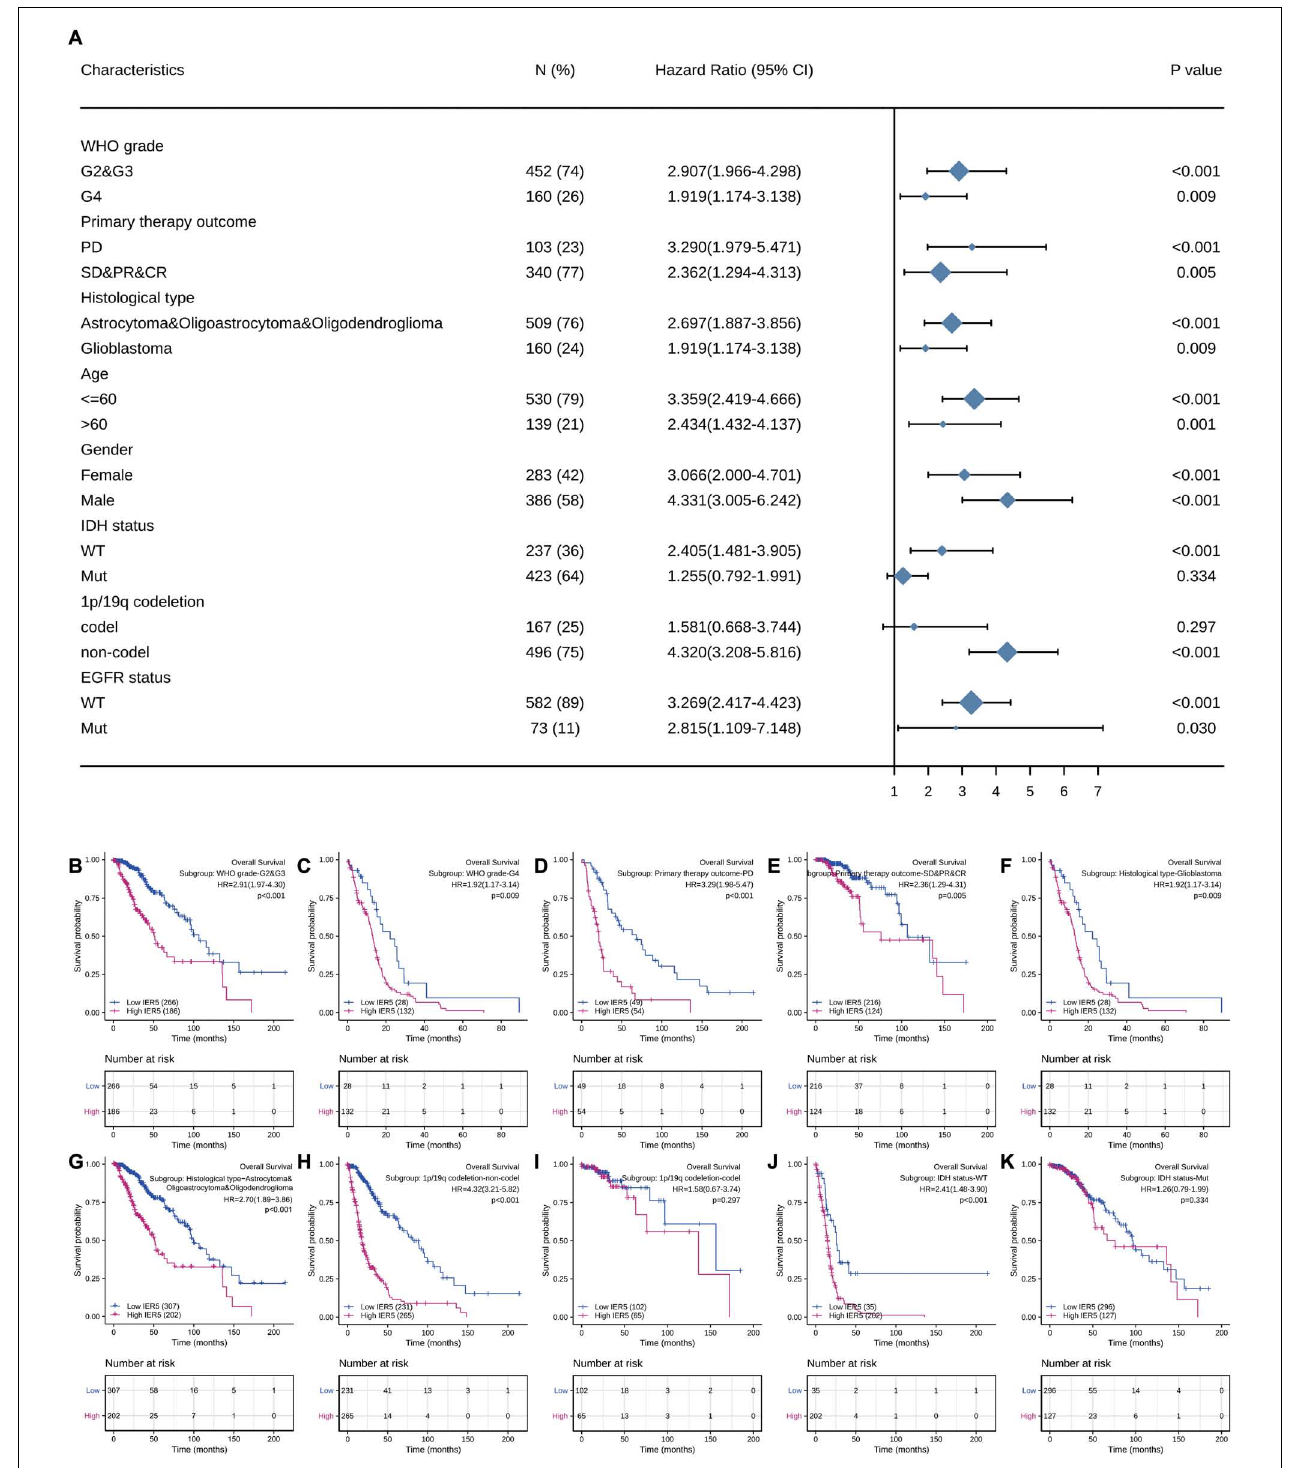
FIGURE 5 | Correlation of IER5 expression and clinical prognosis in glioma patients with different clinicopathological factors. (A) Forest plots showing subgroup analyses of overall survival. (B–K) Kaplan–Meier survival subgroup analysis in patients stratified by clinical characteristics.